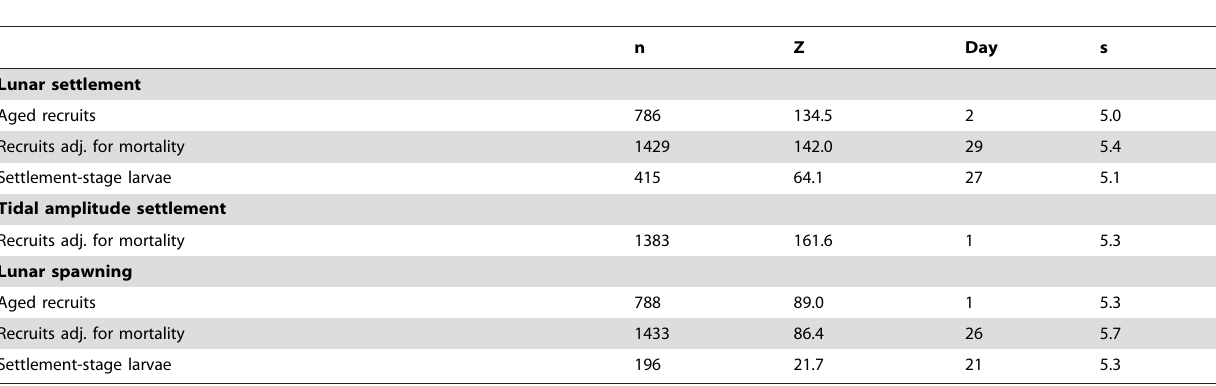
Table 2. Rayleigh statistics for lunar and tidal amplitude synchrony in settlement and successful spawning of Stegastes partitus in the upper Florida Keys.